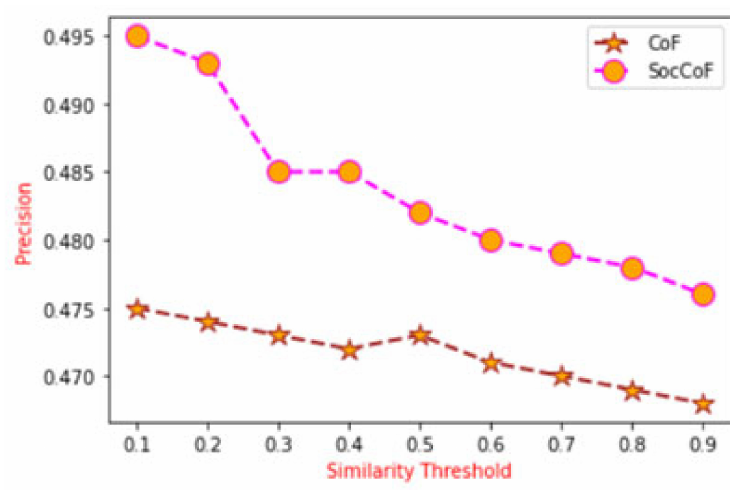
Figure 8. Social information contribution on CoF